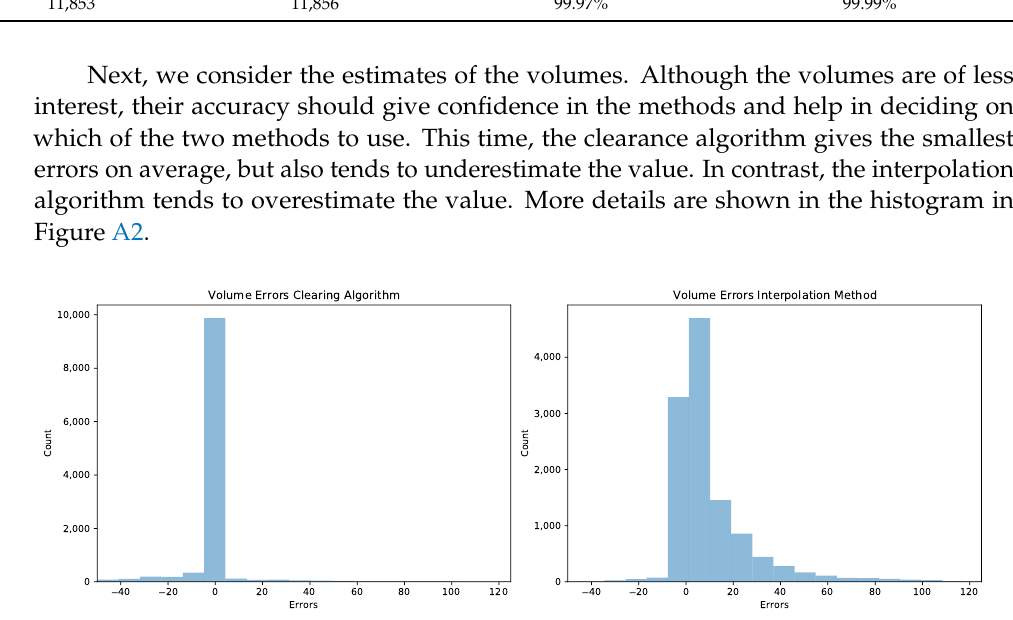
Figure A2. Histogram for the clearing volumes for the clearing algorithm ( left ) and the interpolation method ( right